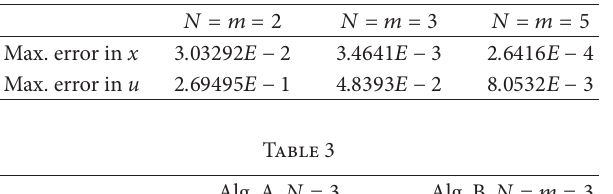
Table 2: Maximum errors in the state x and in the control u for different values of N